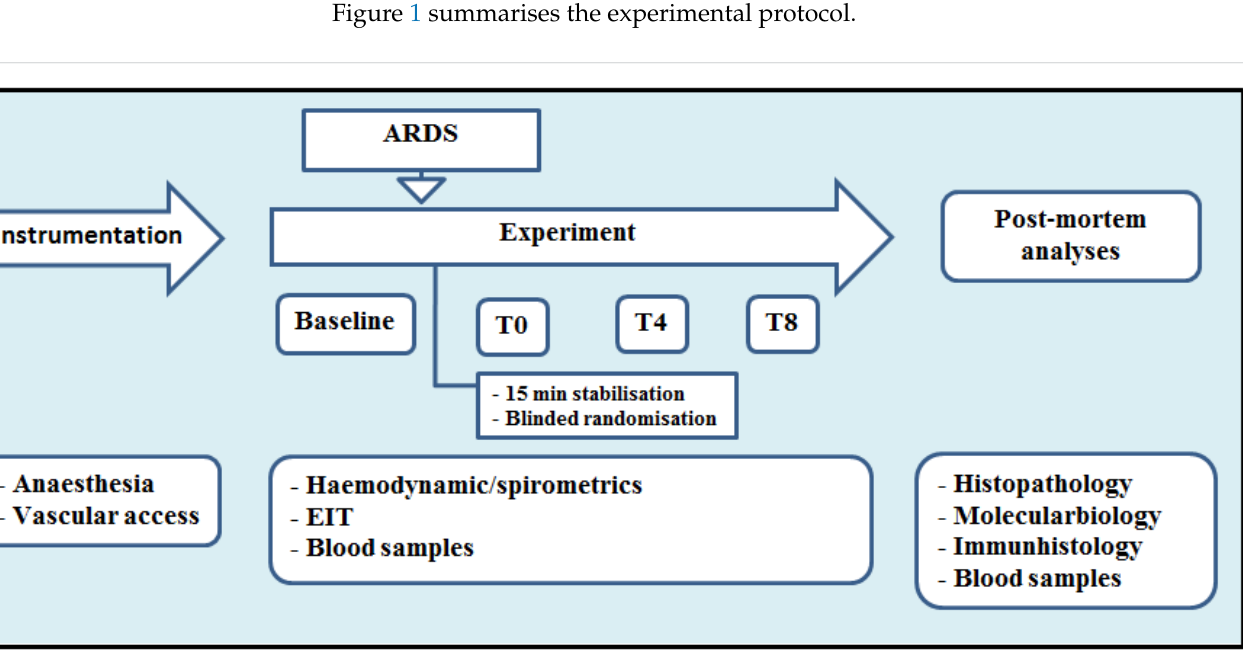
Figure 1. Experimental flowchart. EIT: electrical impedance tomography. ARDS: acute respiratory distress syndrome. T x : timepoint.